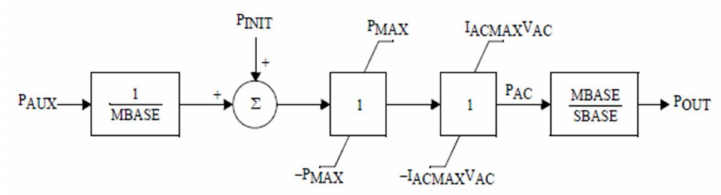
Figure 4. Diagram of CBEST BESS model from PSS/E [28].